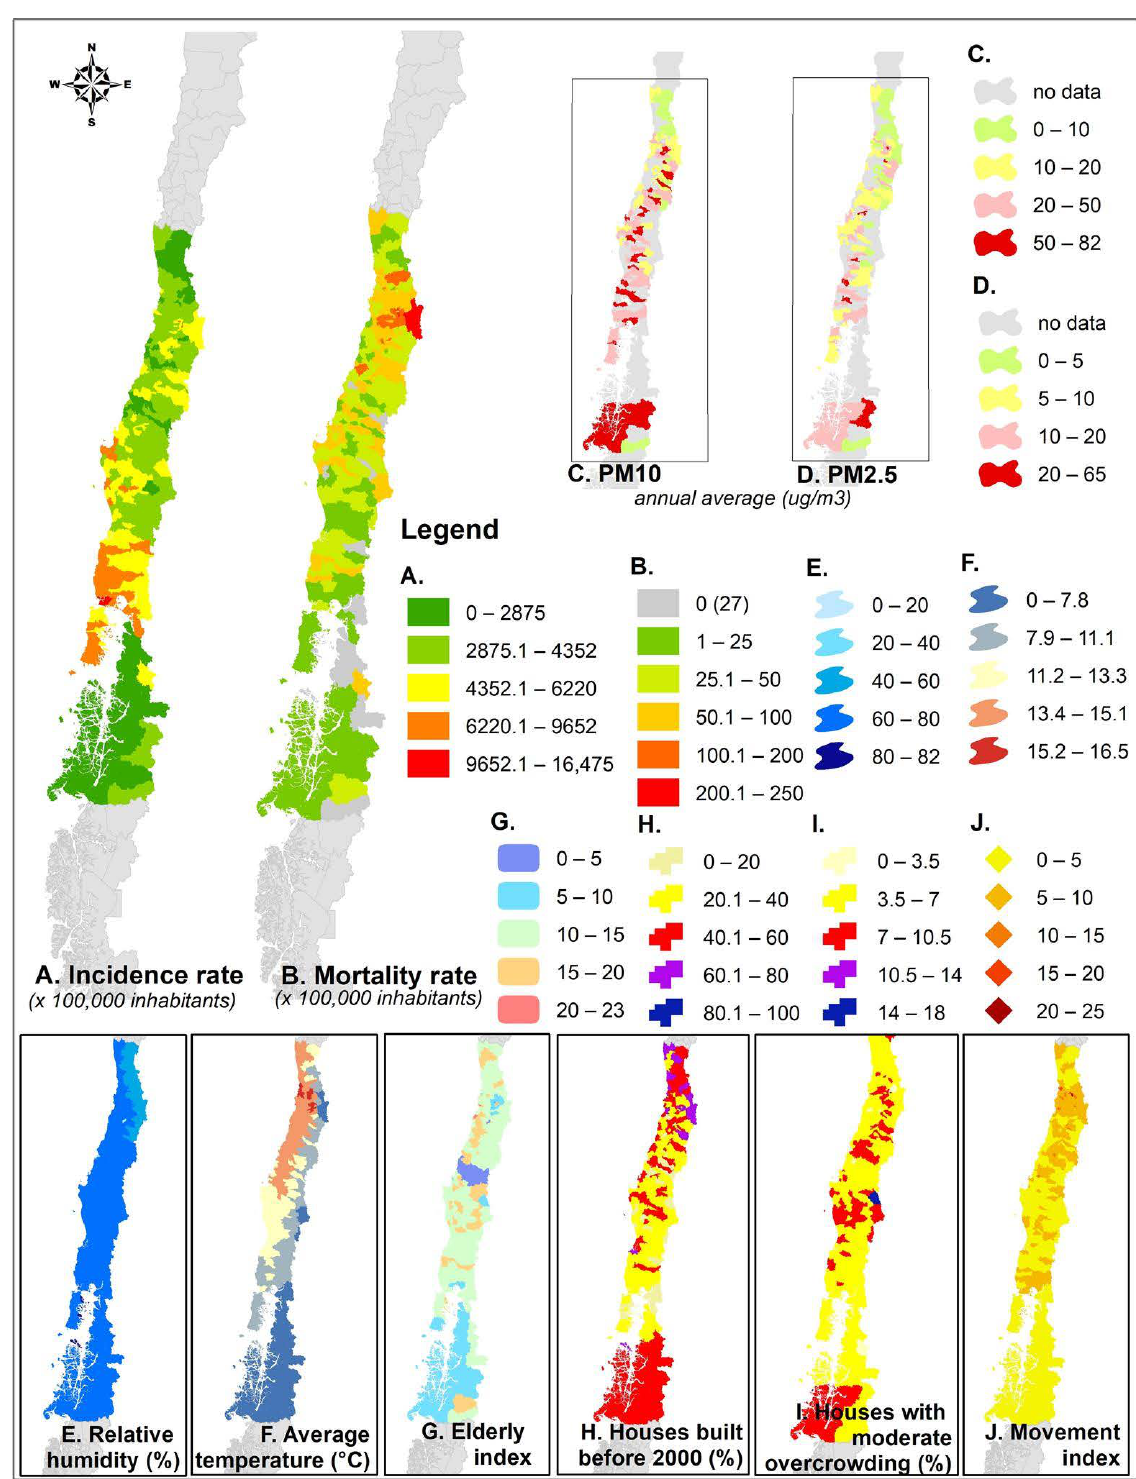
Figure 2. Spatial distribution of incidence and mortality rate, PM 10 , PM 2.5 , relative humidity, annual average temperature, elderly index, % houses built before 2000, % houses with moderate overcrowding, and mobility index.( A ) Incidence of COVID-19 per 100,000 inhabitants during 2020 ( B ) Mortality of COVID-19 per 100,000 inhabitants during 2020; ( C ) Annual average of PM 10 concentration; ( D ) Annual average of PM 5 concentration; ( E ) Annual average of relative humidity; ( F ) Annual average of air temperature; ( G ) Elderly index; ( H ) Percentage of houses built before 2000 year; ( I ) Percentage of houses with moderate overcrowding; ( J ) Movement